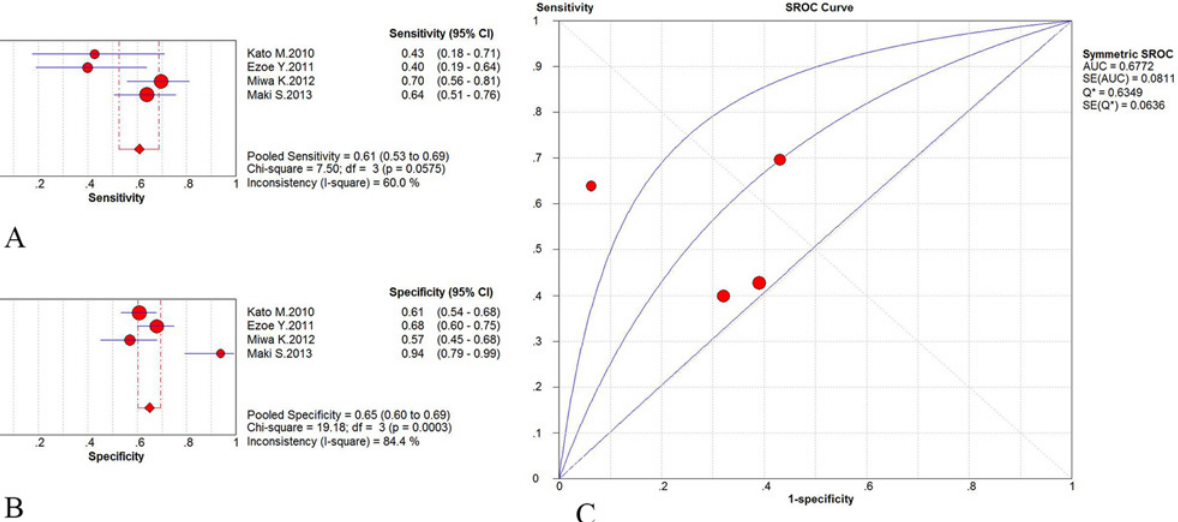
Fig 4. WLI results from the subgroup analysis performed to evaluate the diagnostic efficacy of ME-NBI vs. WLI. A: Pooled sensitivity of WLI in the subgroup analysis. B: Pooled specificity of WLI in the subgroup analysis. C: Symmetric receiver operating characteristic (SROC) curve and area under the curve